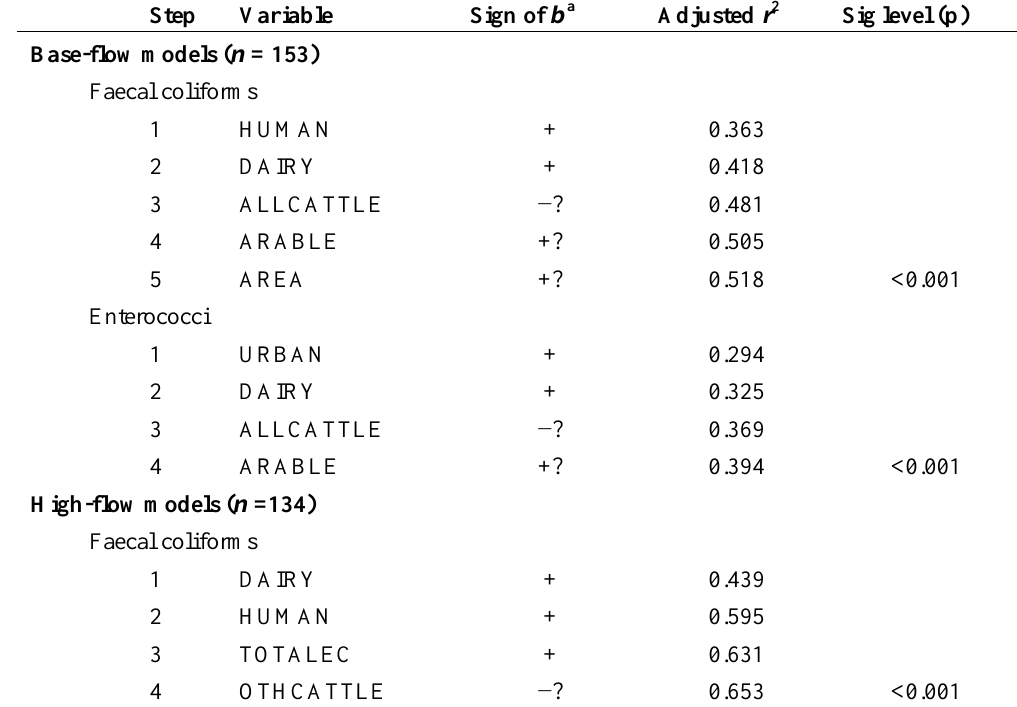
Table 4. Summary of results of stepwise multiple regression models of relationship between log geometric mean faecal coliform and enterococci concentrations at base and 10 high flow and all the independent variables listed in Table